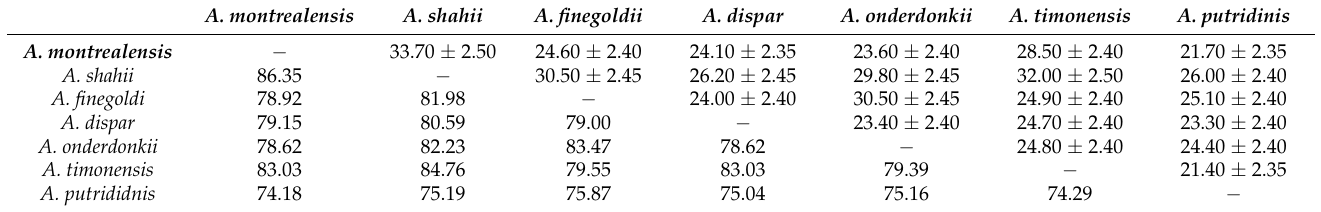
cleotide Identity (ANI, lower left side) values calculated between strain kh20 T and closest related